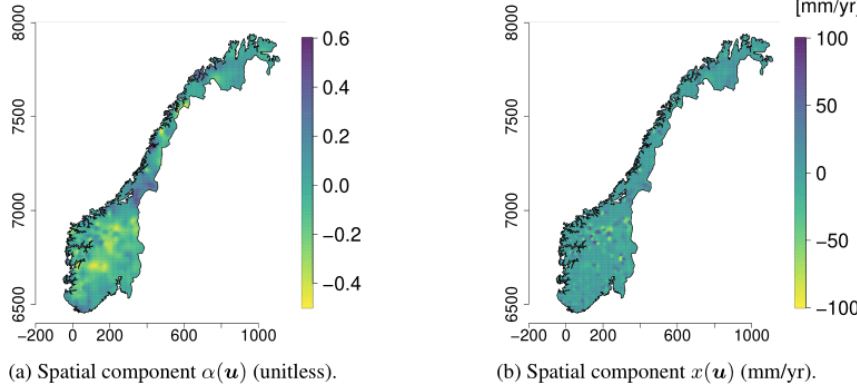
Figure 6. Posterior means for the two GRFs x( u ) and α( u ) for SVC PP for the Norwegian mainland.